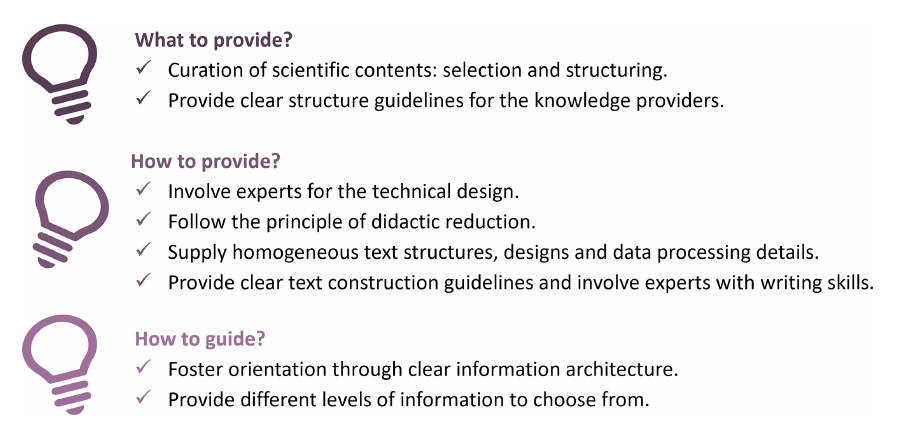
Figure 9. Short form of recommendations for developing DKTPs, categorised along with the key